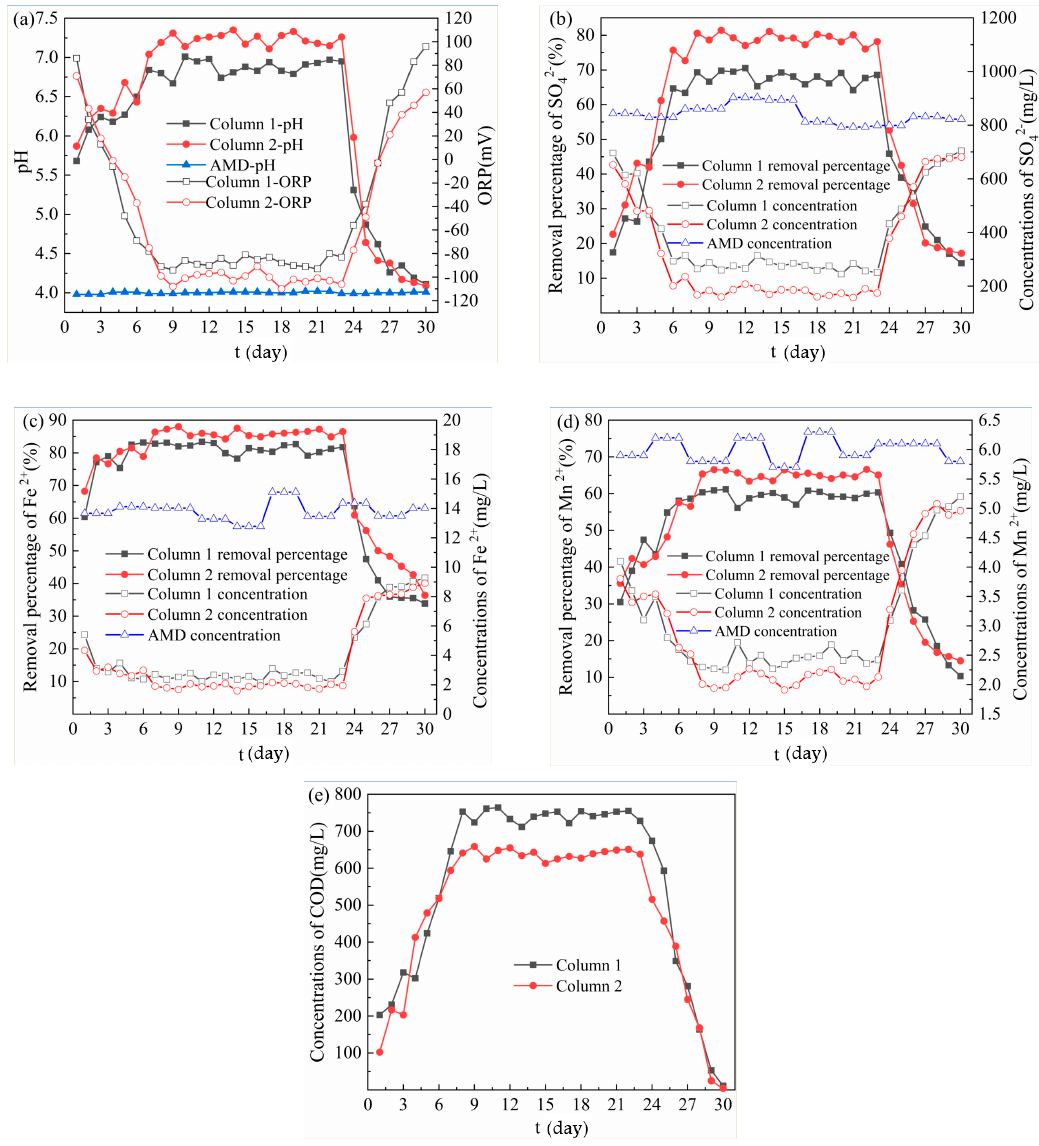
Figure 2. Removal effect of acid mine drainage (AMD) by Column 1 and Column 2. ( a ) Changes of pH and oxidation reduction potential (ORP) values; ( b ) SO 42 − removal effect; ( c ) Fe 2+ removal effect;